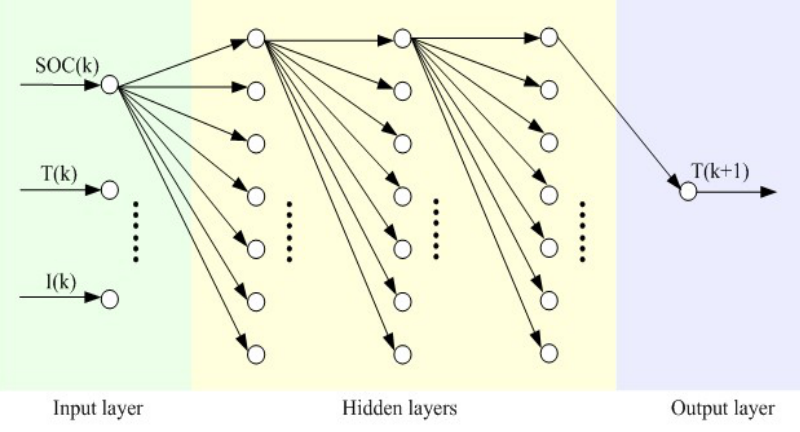
Figure 4. Neural network for predicting battery